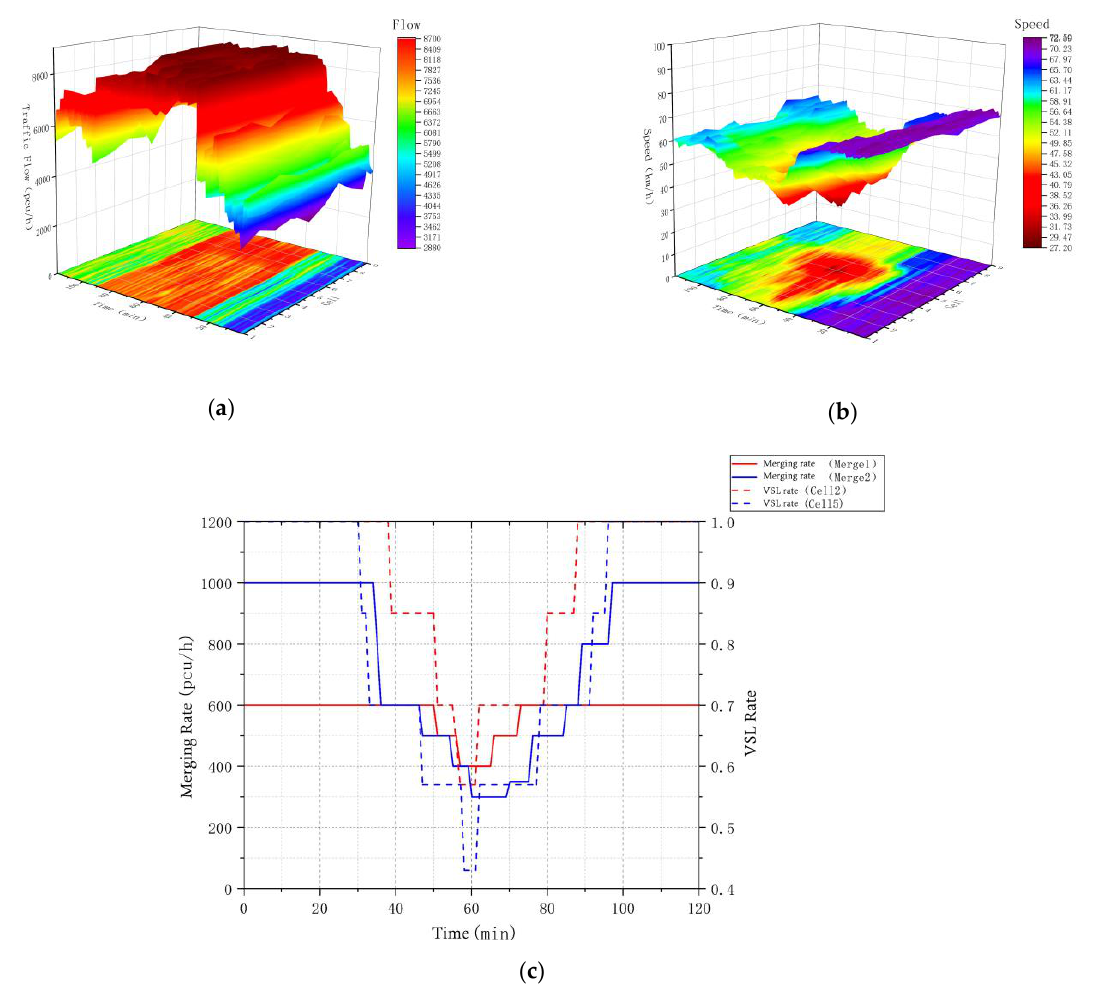
Figure 17. VISSIM output results after the implementation of collaborative control. ( a ) Traffic flow; ( b ) Traffic flow speed; ( c ) Control parameter